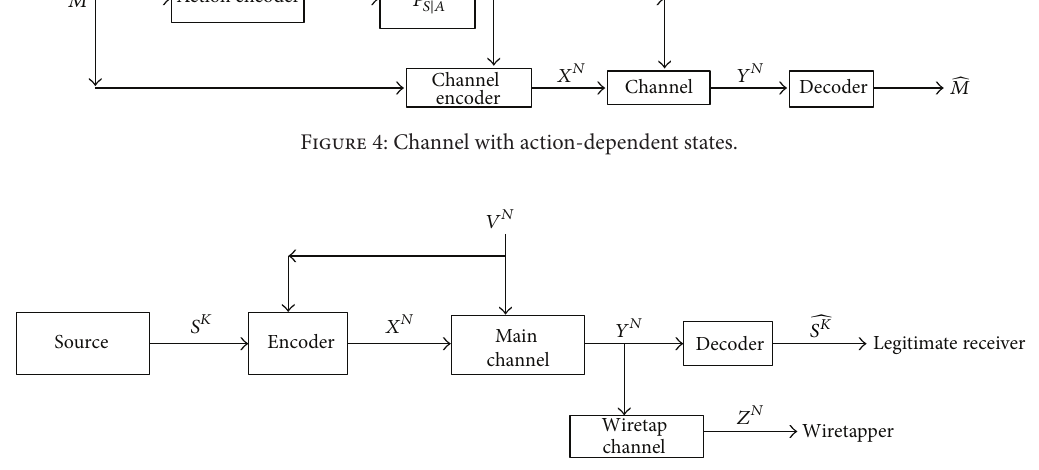
Figure 5: Wiretap channel with noncausal channel state